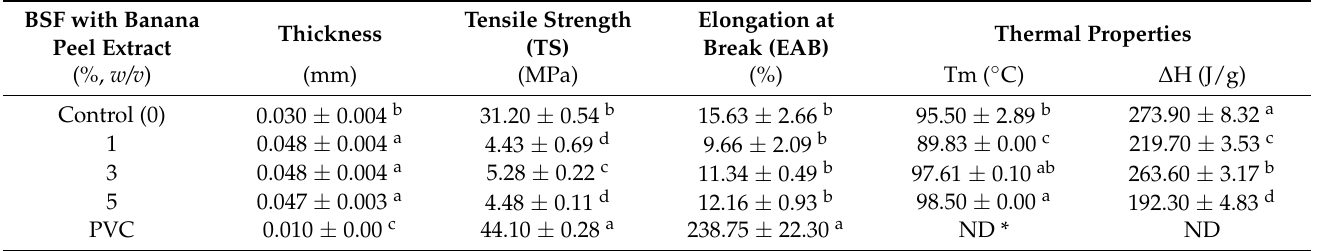
Table 1. Thickness, mechanical properties, and thermal properties of banana starch films incorporated with banana peel extract at different